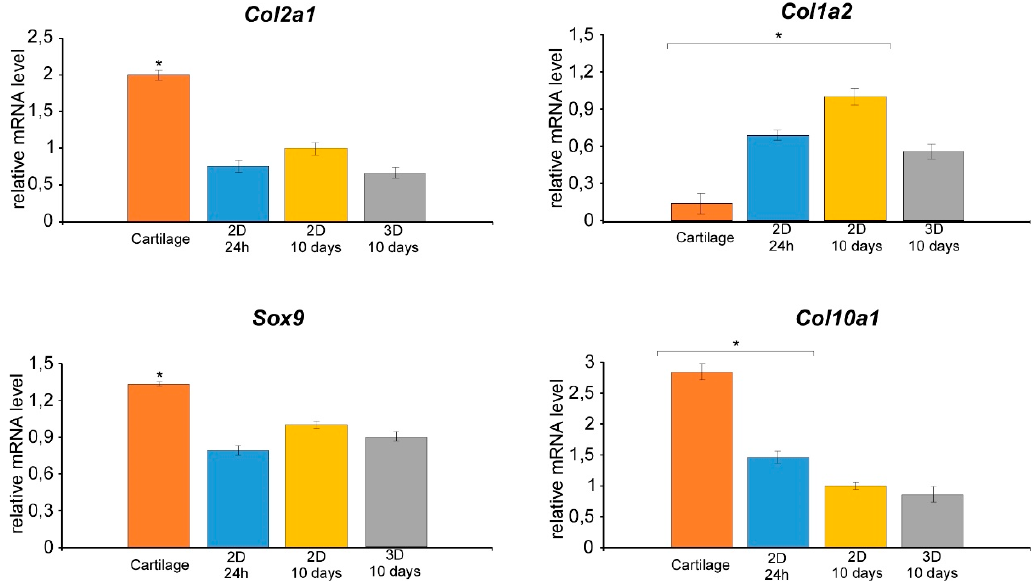
Figure 5. Gene expression analyses of Sox9, Col II, I, and 10 by qRT-PCR. The gene expression levels were analyzed using the 2 −ΔΔ Ct method using β -actin, 18S rRNA, and GAPDH as the internal controls. The data represent the mean ± SD of three independent culture experiments. Bars with different letters are significantly different from each other at P < 0.05.